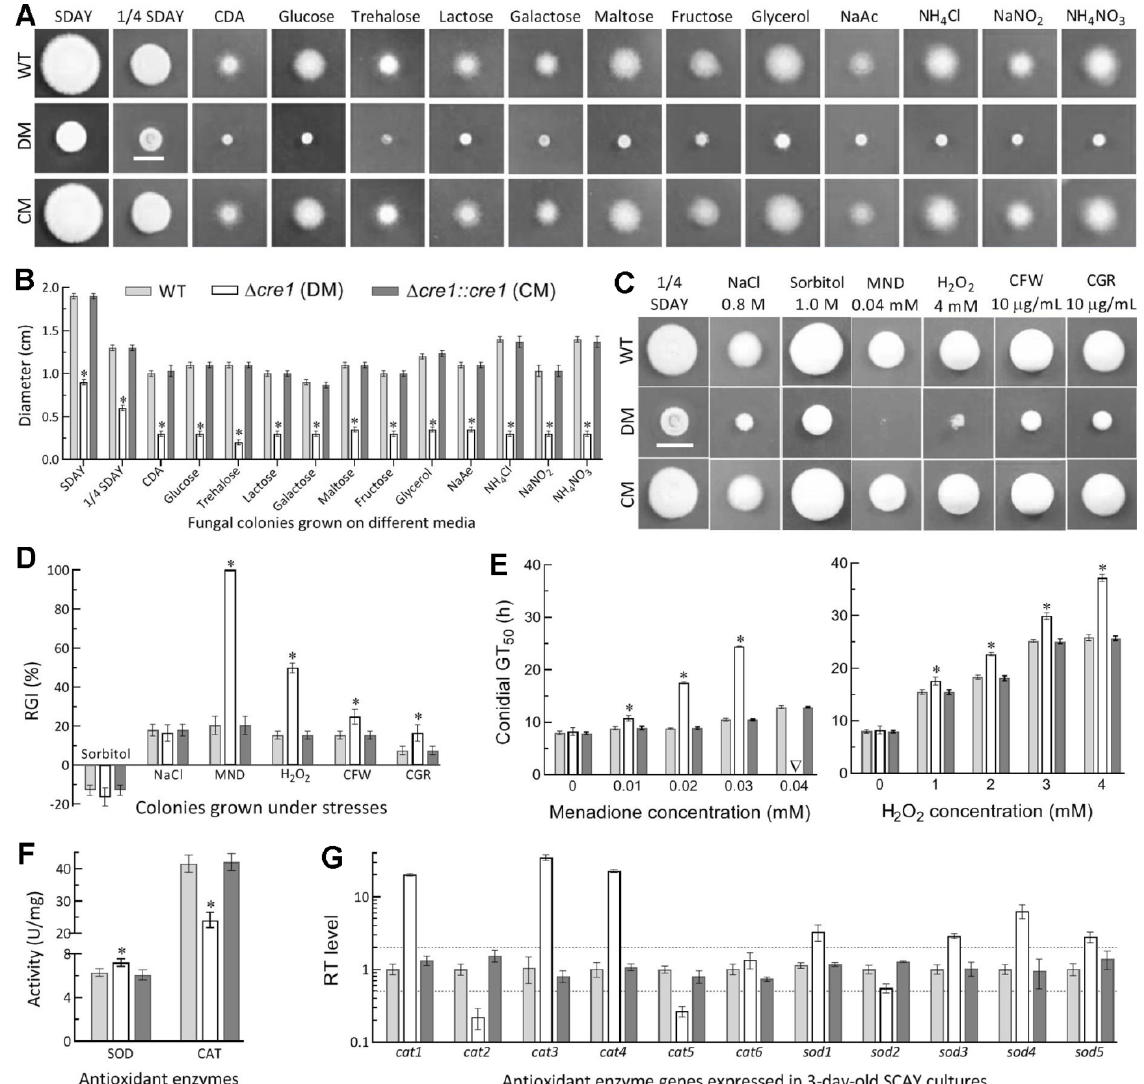
Figure 3. Impacts of cre1 deletion on radial growth under normal and stressful conditions. ( A , B ) Images (scale: 10 mm) and diameters of 6-day-old colonies grown at 25 °C on rich SDAY, 1/4 SDAY, minimal CDA and CDAs amended with different carbon or nitrogen sources. ( C , D ) Images of fungal colonies grown on 1/4 SDAY alone (control) or supplemented with the indicated concentrations of chemical stressors (MND, menadione; CGR, Congo red; CFW, calcofluor white) and relative growth inhibition (RGI) percentages of fungal strains under the stresses. All colonies were initiated by spotting 1 µ L aliquots of a 10 6 conidia/mL suspension. ( E ) GT 50 estimates for 50% of conidial germination at 25 ◦ C on TPA alone (control) or supplemented with 0.01–0.04 mM of menadione and 1–4 mM of H 2 O 2 respectively. ( F ) Total activities of superoxide dismutases (SOD) and catalases (CAT) quantified from the protein extracts of 3-day-old SDAY cultures. ( G ) Relative transcript (RT) levels of SOD and CAT genes in the 3-day-old SDAY cultures of cre1 mutants with respect to the WT standard. The dashed lines indicates a significant level of one-fold down- or upregulation. * p < 0.05 in Tukey’s HSD tests. Error bars: SDs of the means from three independent